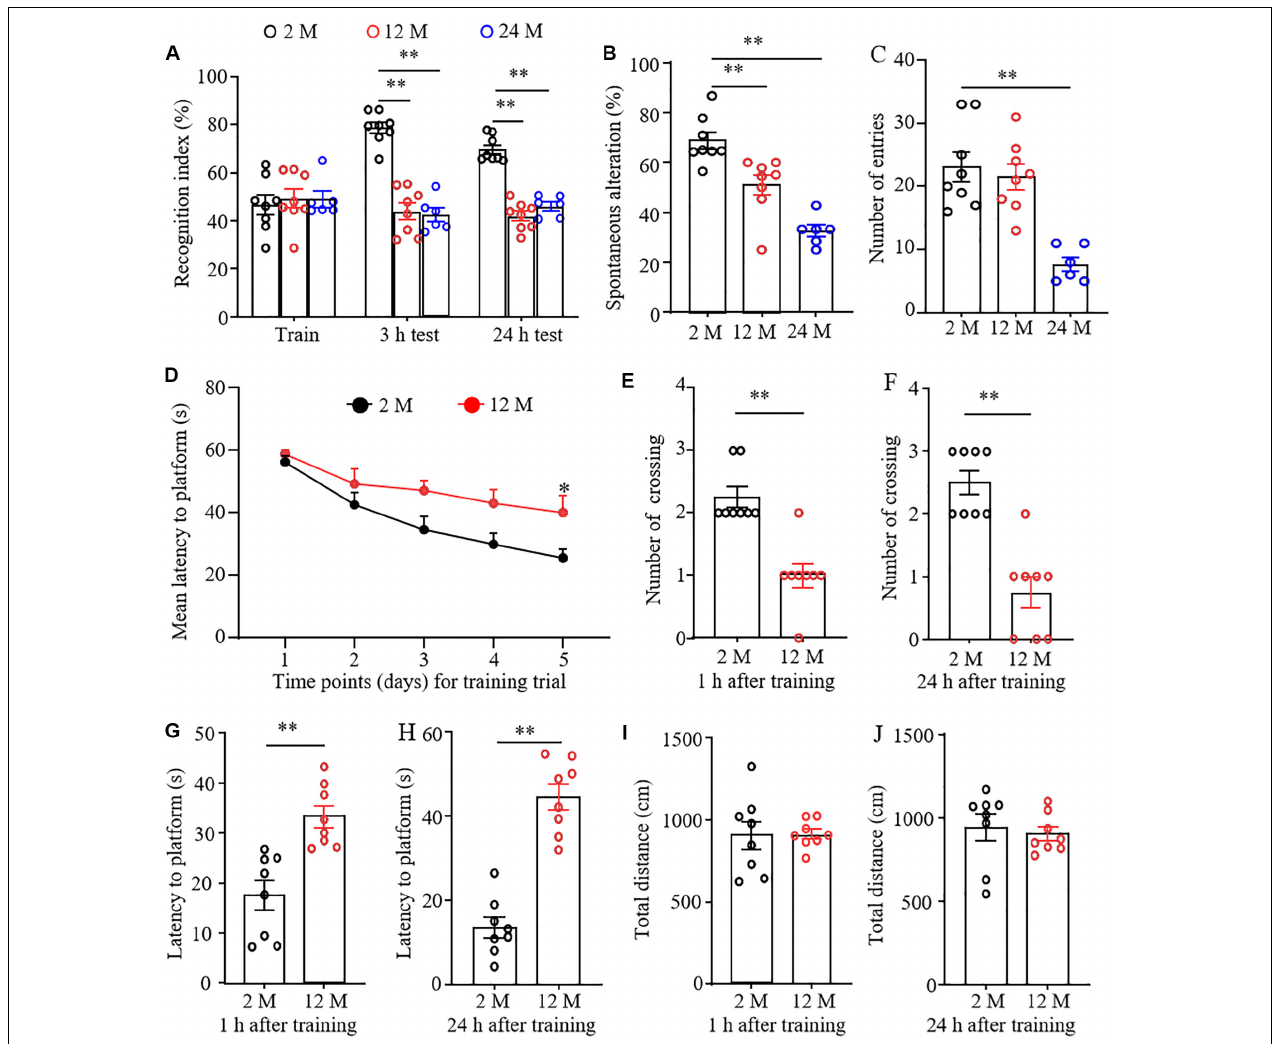
FIGURE 1 | The cognitive dysfunction in aging mice. n = 8 for 2- or 12-month mice, n = 6 for 24-month mice. Data were shown as mean ± SEM. (A) The recognition indexes were significantly reduced in 12- and 24-month old mice as compared to 2-month old mice at 3 and 24 h after the training session in the novel object recognition test. ∗∗ P < 0.01 versus the corresponding 2-month old mice by two-way ANOVA with repeated measures followed by post hoc Tukey test. (B) The percentages of spontaneous alterations were significantly reduced in 12- and 24-month old mice as compared to 2-month old mice in the Y maze test. ∗∗ P < 0.01 versus the corresponding 2-month old mice by one-way ANOVA with repeated measures followed by post hoc Tukey test. (C) The number of arm entries was significantly reduced in 24-month old mice, but not in 12-month old mice in the Y maze test. ∗∗ P < 0.01 versus the corresponding 2-month old mice by one-way ANOVA with repeated measures followed by post hoc Tukey test. (D) The learning curve was examined for 5 days in the Morris water maze test. ∗ P < 0.05 versus 2-month old mice at the corresponding time point by two-way ANOVA with repeated measures followed by post hoc Tukey test. (E,F) Platform crossing times in the probe trial of the MWM test at 1 (E) and 24 h (F) after the training session. ∗ P < 0.01 versus 2-month old mice by two-tailed unpaired Student’s t -test. (G,H) The average escape latency to reach the previous platform location was examined at 1 (G) and 24 h (H) after the training session. ∗∗ P < 0.01 versus 2-month old mice by two-tailed unpaired Student’s t -test. (I,J) Total distance of movement was examined at 1 (I) and 24 h (J) after the training session. Two-tailed unpaired Student’s t